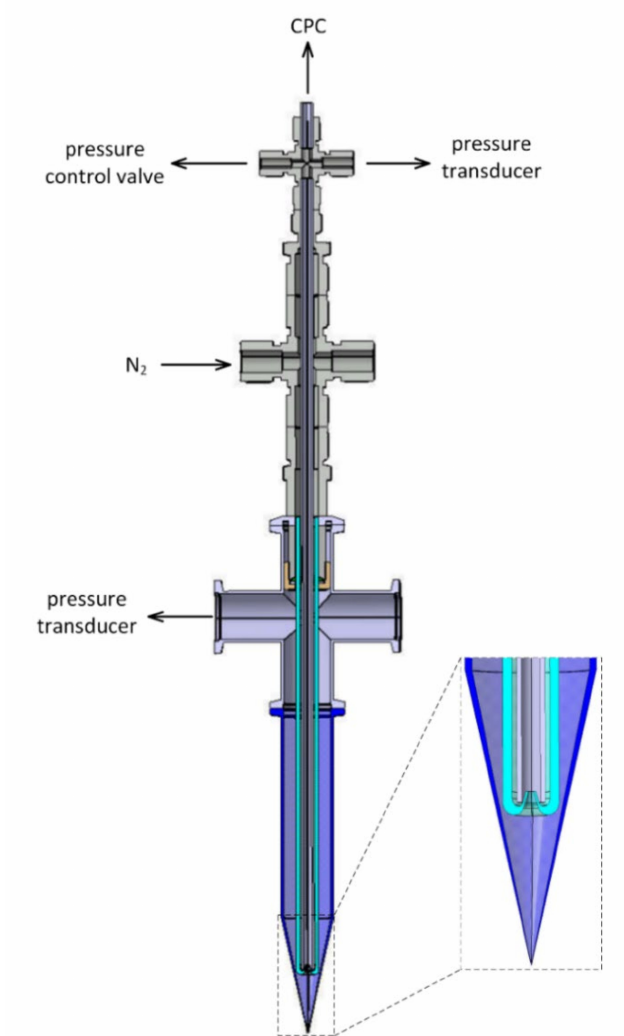
Figure 3. Scheme of the sampling unit used for the measurement of the sooting propensity (inlets, as they were not labeled, were closed during the measurement); CPC—condensation particle